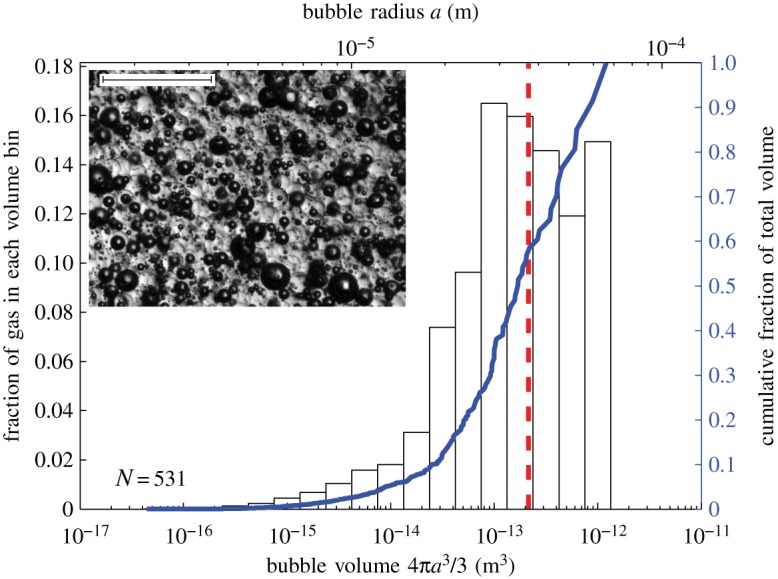
Bubble size distribution for sample 3P-42 (ϕp=0.42 and ϕb=0.29). Histogram shows the fraction of the total bubble volume in the sample represented in each volume bin. Solid line shows the cumulative fraction of the total bubble volume. Dashed line is the volume-mean-radius 〈a〉∼37 μm (see §4c). Inset shows photomicrograph of sample, in which dark-rimmed spheres are bubbles, and glass beads are light and translucent. Scale bar, 500 μm. (Online version in colour.)